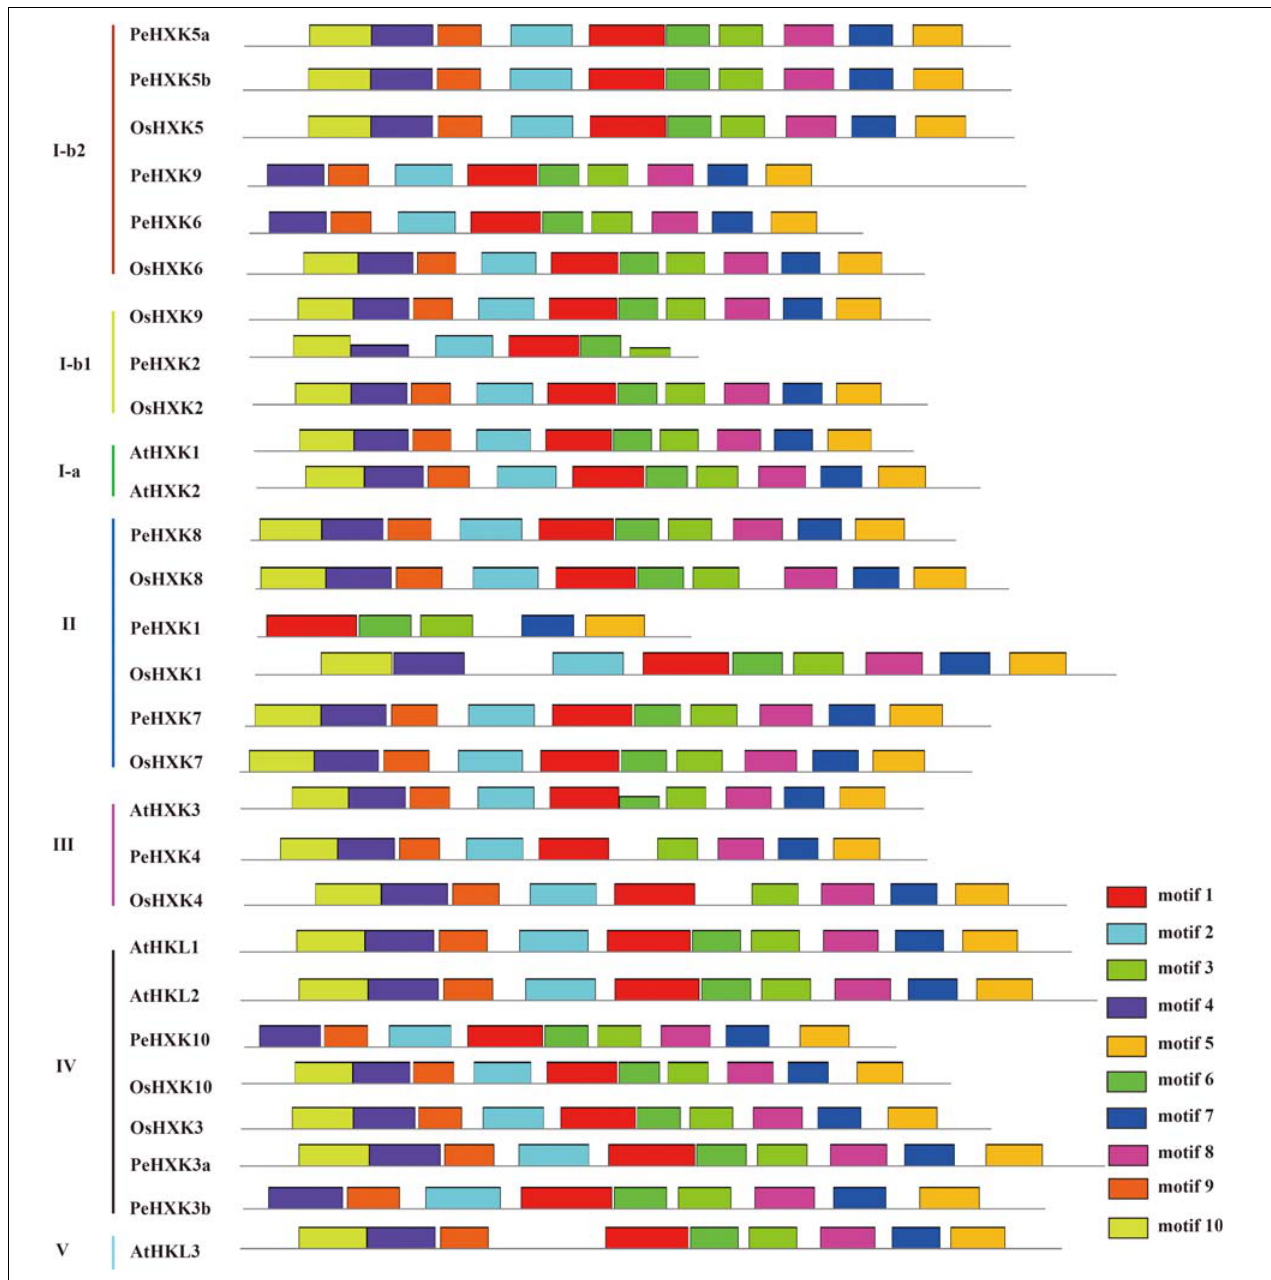
FIGURE 4 | Motif distribution in HXKs from moso bamboo, Arabidopsis thaliana , and rice. Motifs were analyzed using the MEME web server (https://www.swissmodel.expasy.org/). The motifs are represented by different colors. The length of each box in the figure does not represent the actual motif